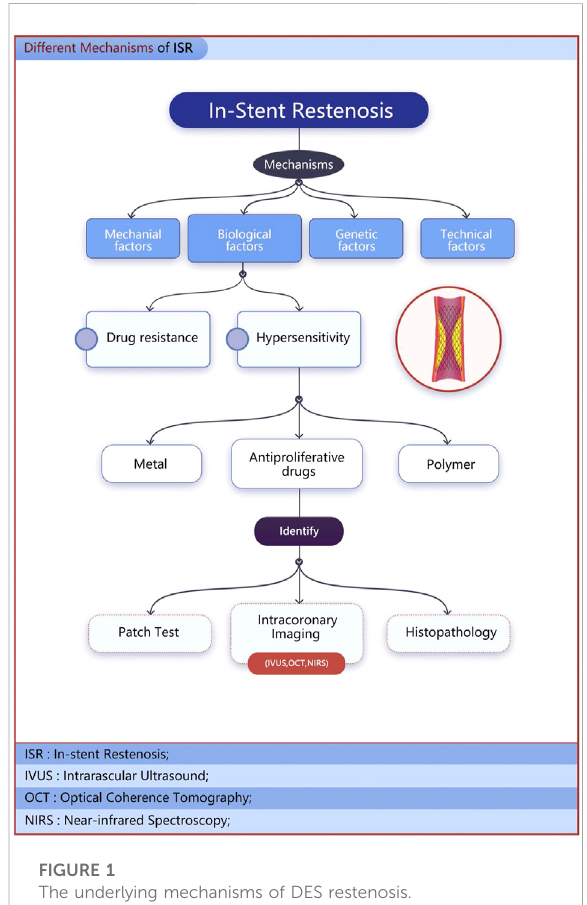
FIGURE 1 The underlying mechanisms of DES